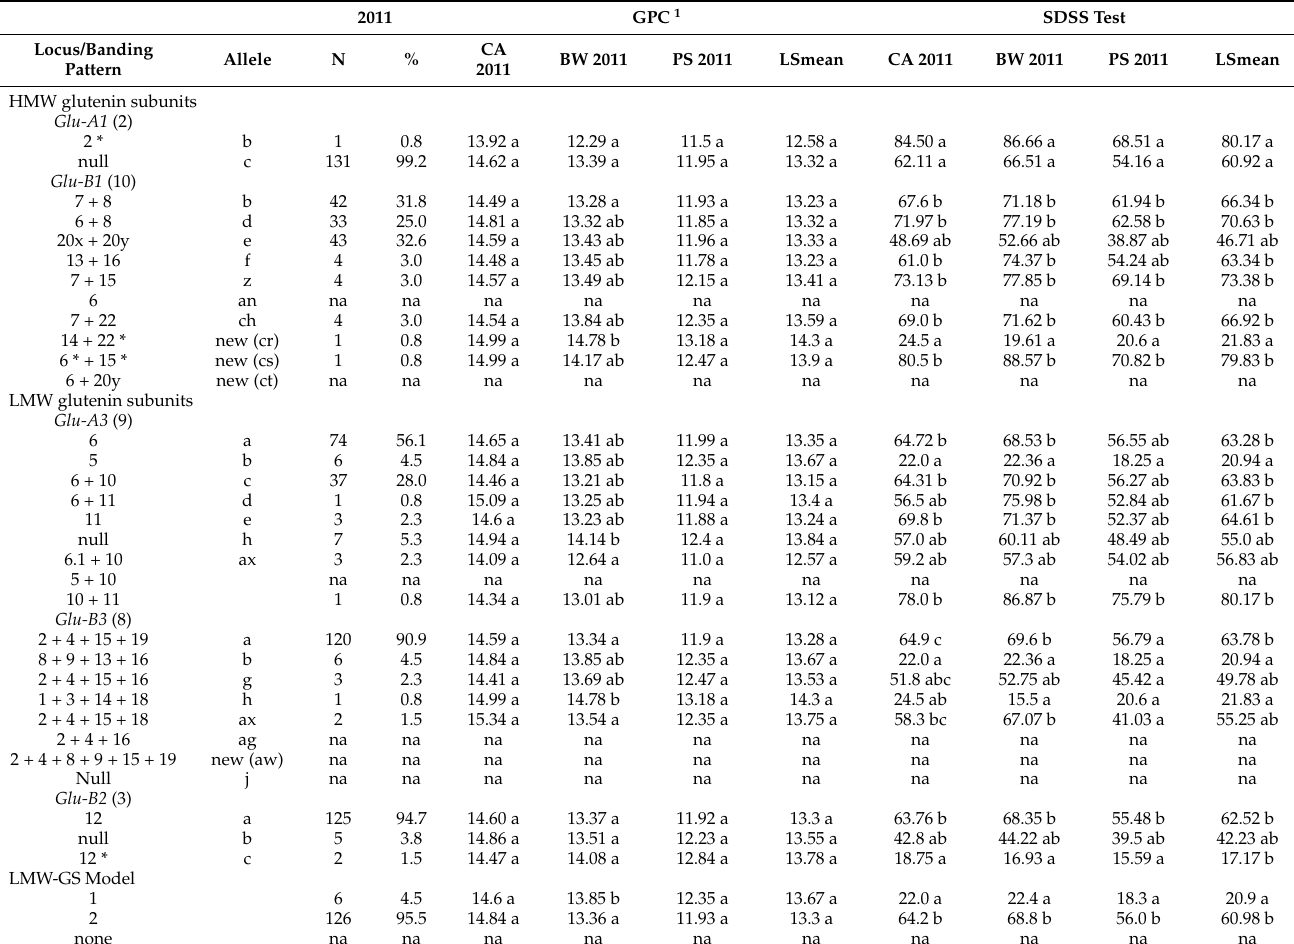
GPC 1 SDSS Test